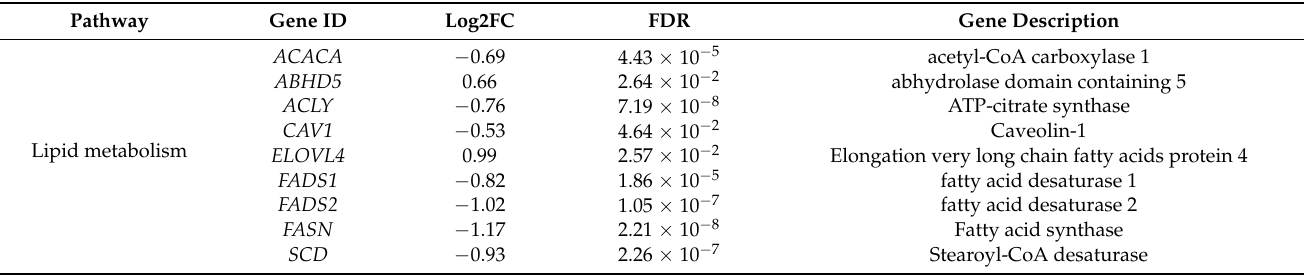
Figure 2. TOP GO categories for biological processes in gene expression altered by 15 μM 7KCh in mRPE cells. DEGs between control and 7KCh-treated cells for 24 h were used to perform Gene Ontology (GO) enrichment analysis. The annotated DEGs were classified into different categories according to GO terms by EnrichGO. Functional groups are shown on the y -axis, while the gene ratio of each category is displayed on the x -axis. Table 1. Relevant genes and associated pathways altered in mRPE cells treated with 15 μM 7KCh for 24 h. Positive Log2FC (FC, Fold Change) represents upregulated genes, while negative Log2FC represents downregulated genes.